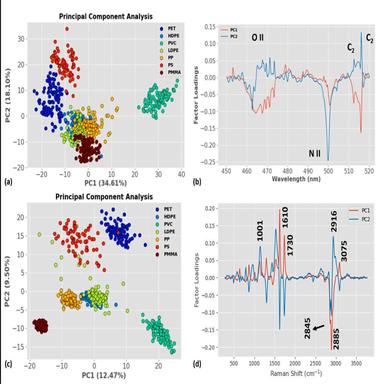
PCA analysis result on LIBS-Raman data: (a) score pot for the LIBS data collected from 7 plastic classes, (b) factor loadings plot for LIBS data, (c) score pot for the Raman data collected from 7 plastic classes, and (d) factor loadings plot for Raman data.